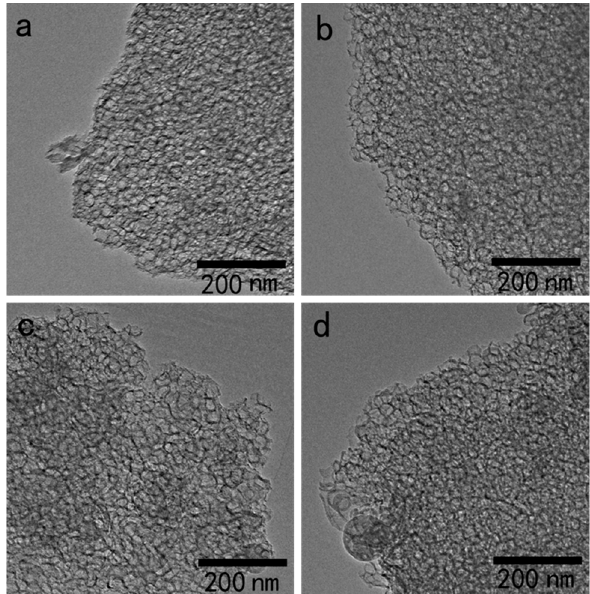
Figure 2. TEM images of MCF ( a ), [BMIM] 3 PMo 12 O 40 -based MCF ( b ), [BMIM] 3 PW 12 O 40 -based MCF ( c ), and [BMIM] 4 SiW 12 O 40 -based MCF ( d ). ( c ), and [BMIM] 4 SiW 12 O 40 -based MCF ( d